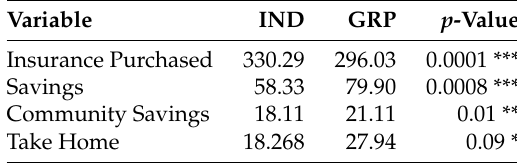
Table 4. Mean Endowment Allocation Across Individual (IND) and Group (GRP)